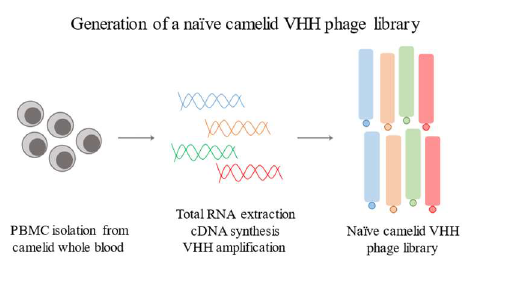
Figure 1. Schematic overview of performed phage display procedure to generate anti-short nucleic acid camelid binders. ( a ) The first step was the generation of a naïve camelid VHH phage library. The peripheral blood mononuclear cells (PBMCs) were isolated from the camelid whole blood. Next, the total RNA was extracted. cDNA synthesis and VHH amplification were performed to build a naïve camelid VHH phage library. ( b ) After several panning rounds, the potential anti-DCM- miRNA VHH_19 binder was identified. In order to produce the recombinant full-length camelid antibody, the DNA sequence was expanded by the introduction of the Fc region of camelid IgG2b instead of His (blue bar) and HA (red bar) tags.